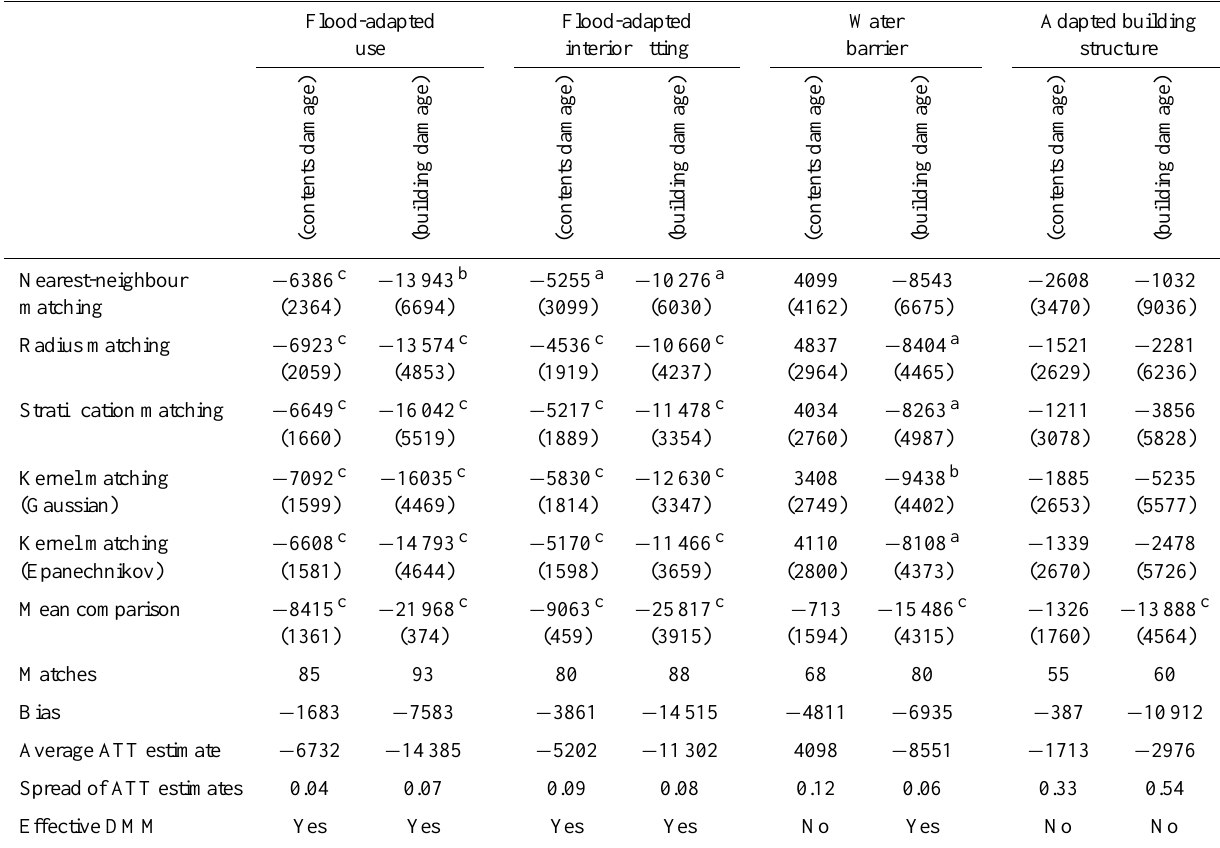
Table 2. Estimates of the effectiveness of private DMM [in Euros]. Flood-adapted Flood-adapted Water Adapted building use interior fitting barrier structure